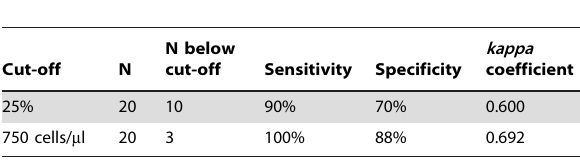
Table 8. Clinical agreement between PointCare NOW and Reference method at 2010 WHO guidelines for